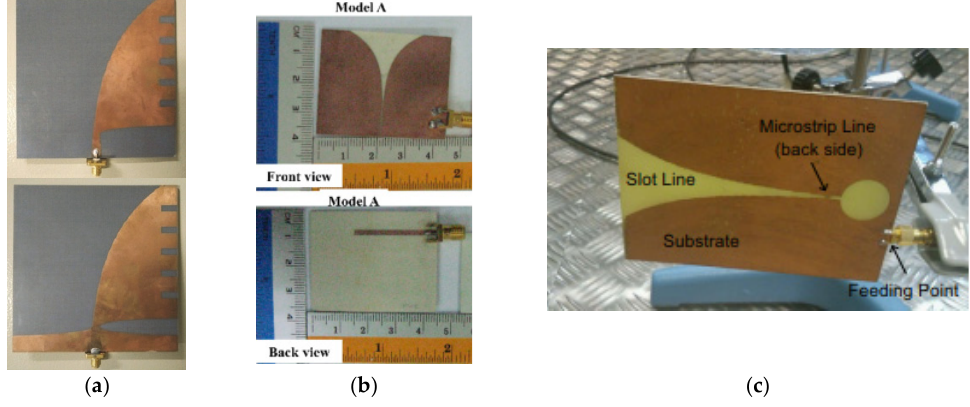
Figure 22. Aperture antennas: ( a ) antipodal Vivaldi antenna used in [132], ( b ) compact UWB Vivaldi tapered slot antenna [133], and ( c ) Vivaldi antenna studied in [134].